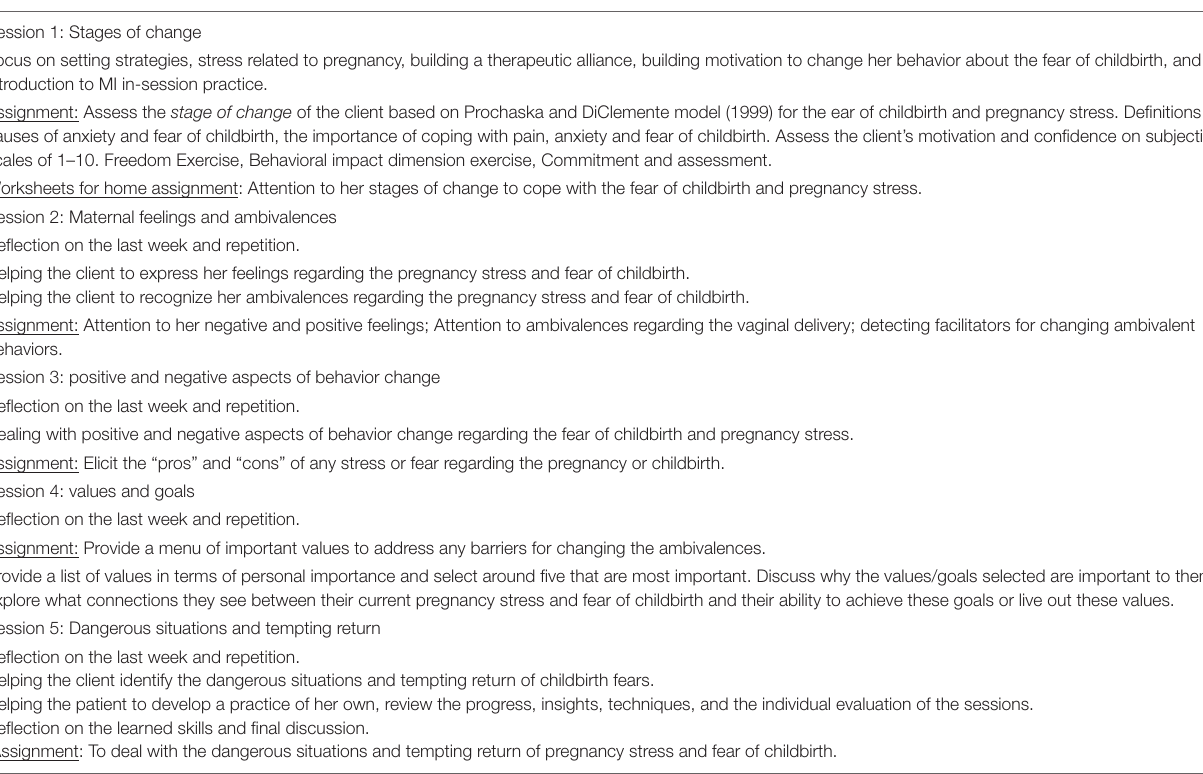
TABLE 1 | Outline of the motivational interviewing sessions for the fear of childbirth and pregnancy stress in pregnant women. Session 1: Stages of